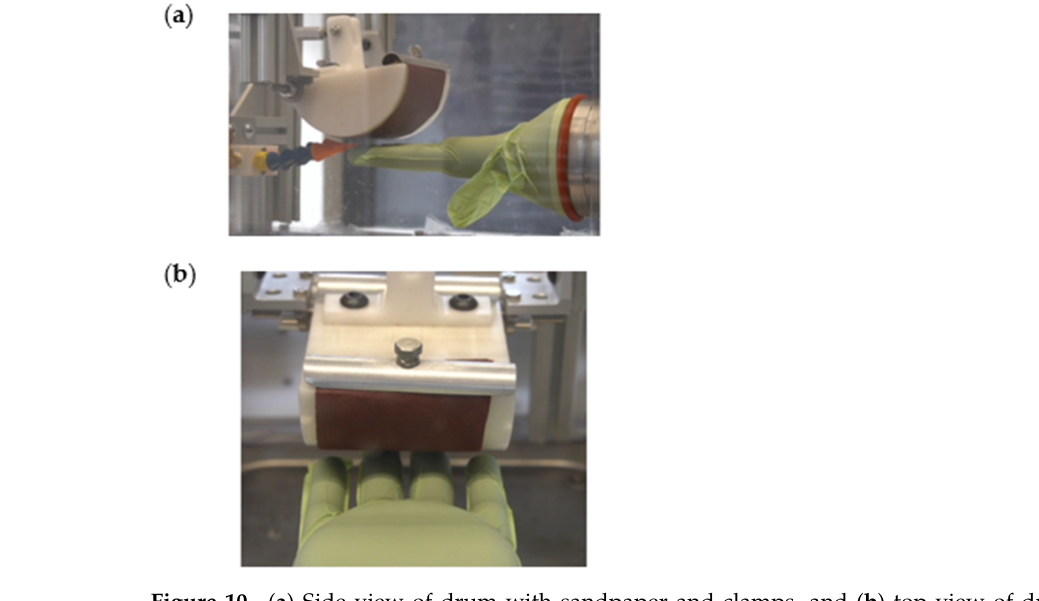
Figure 11. Diagram of the connections between the drum, motor, and control system.